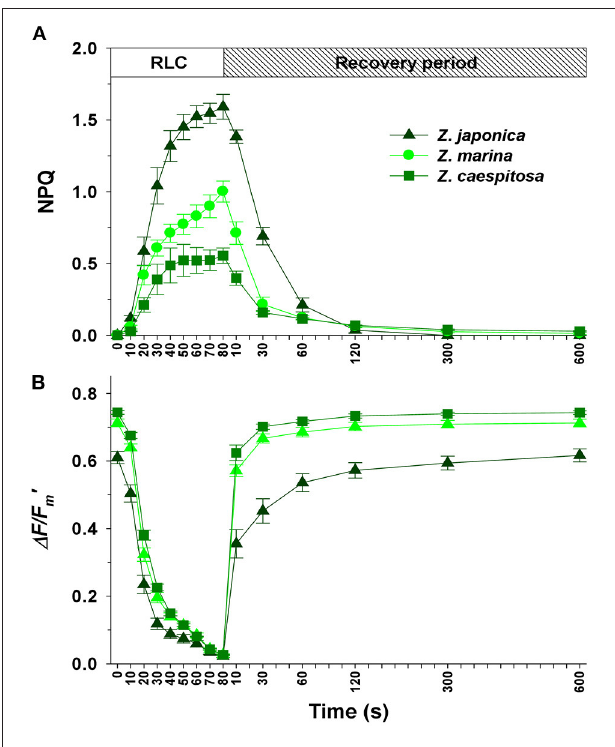
FIGURE 9 | Rapid light curves (RLC) + recovery for the leaves of Z. japonica , Z. marina , and Z. caespitosa . The Stern-Volmer non-photochemical quenching (NPQ; A ) and effective quantum yield ( 1 F / F m ’ ; B ) are plotted against time. Values are expressed as mean ± SE ( n = 6).